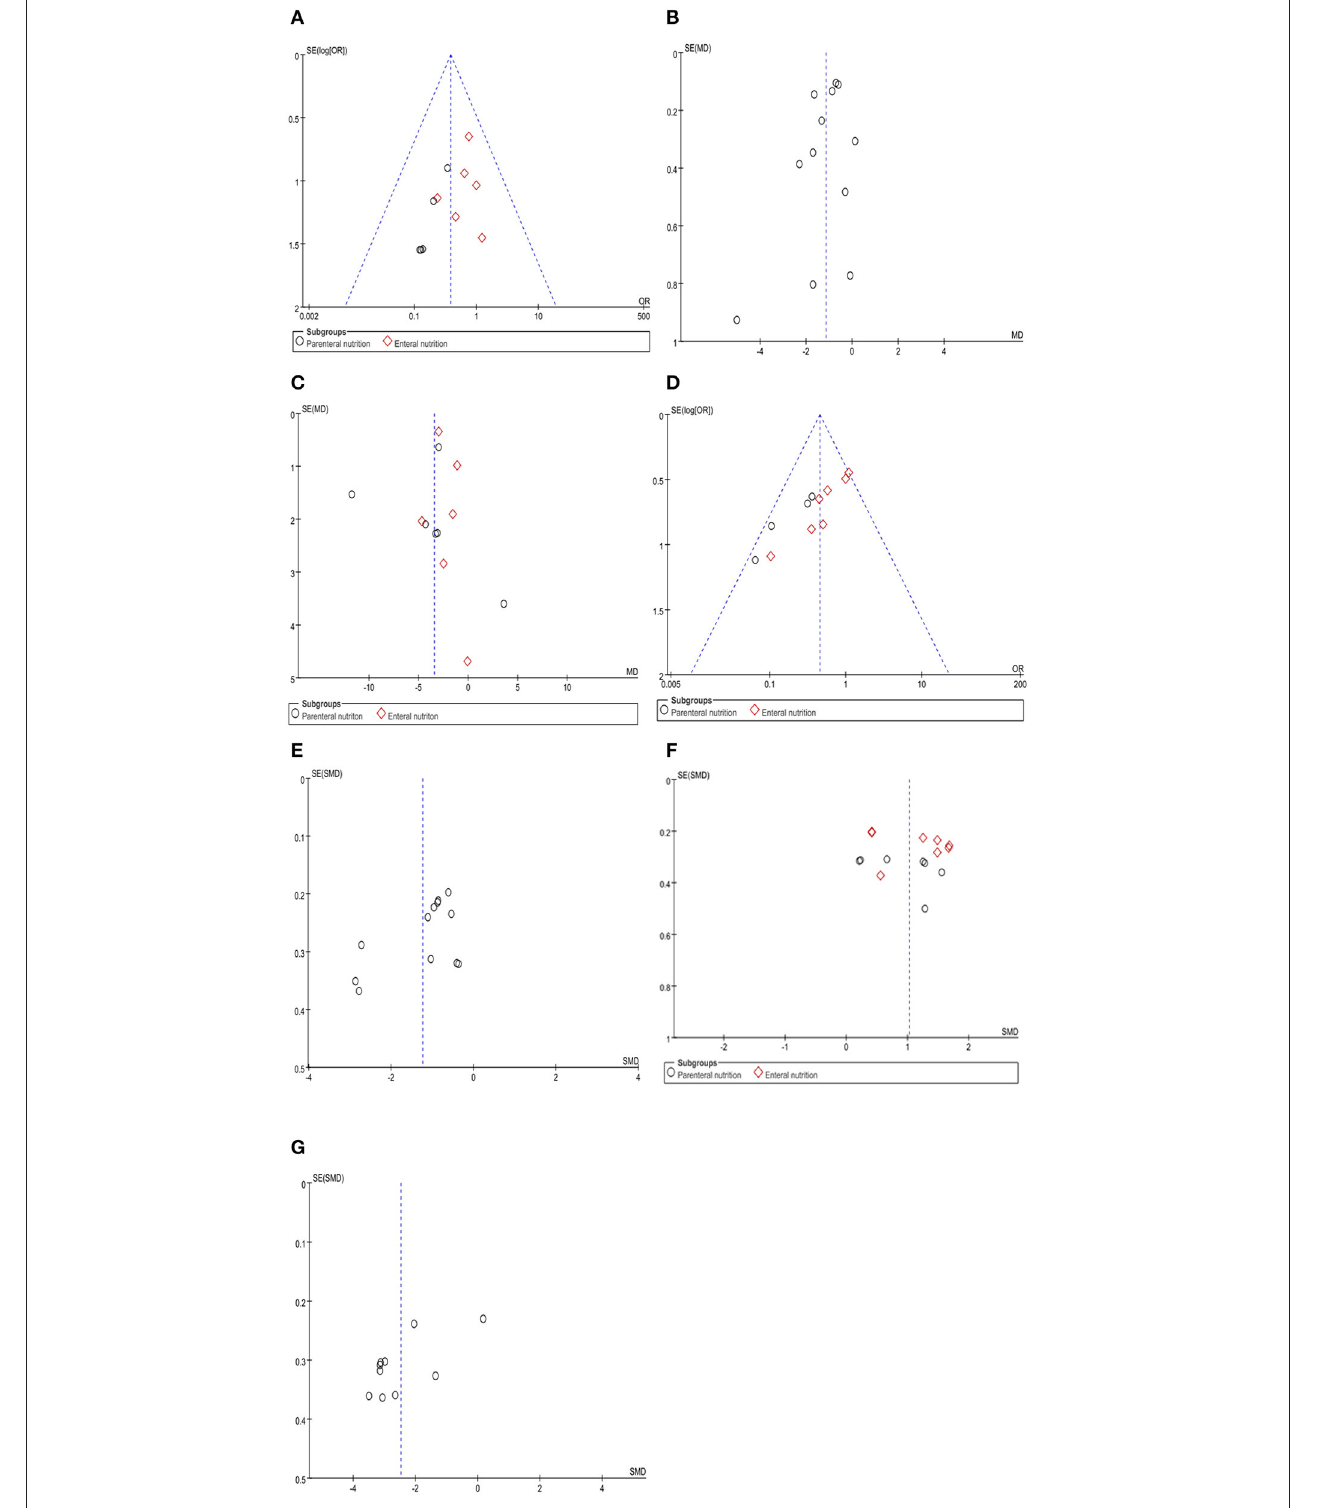
FIGURE 24 | Funnel plots of the included studies for mortality (A) , APACHE II score (B) , total length of hospital stay (C) , complications (D) , serum albumin (F) , IL-6 (E) , and TNF- α (G) .